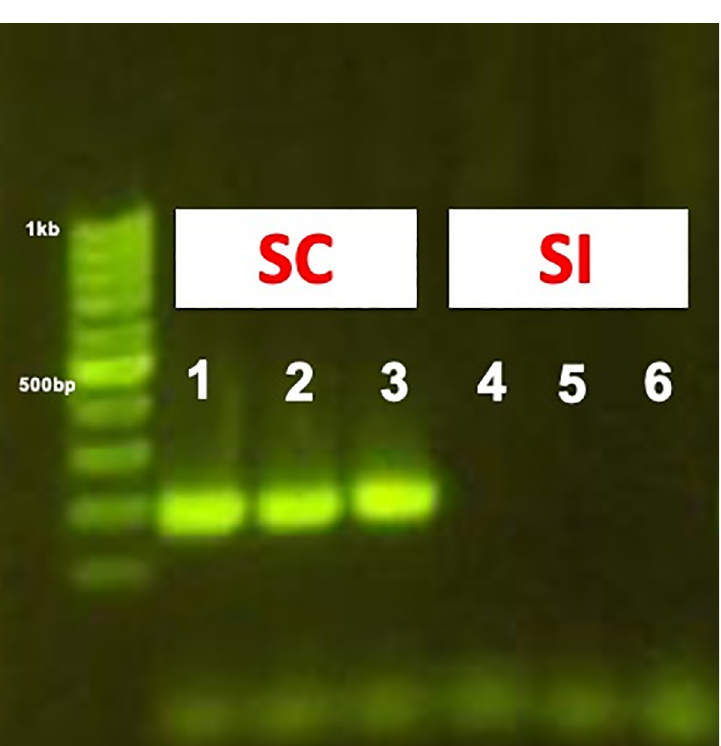
Fig 3. Example of efficacy of the new S marker tested in three SC and three SI samples. Improved French (1), 17 Sutter (2), Muir Beauty (3), Tulare Giant (4), 18S-50 (5) and 6N-103